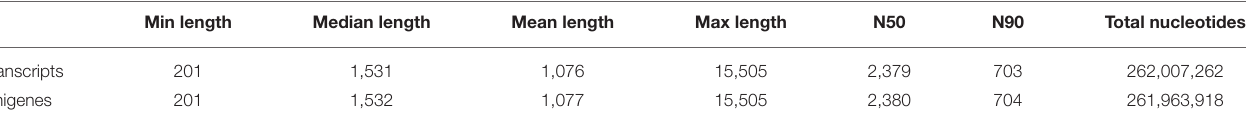
TABLE 3 | Unigene length